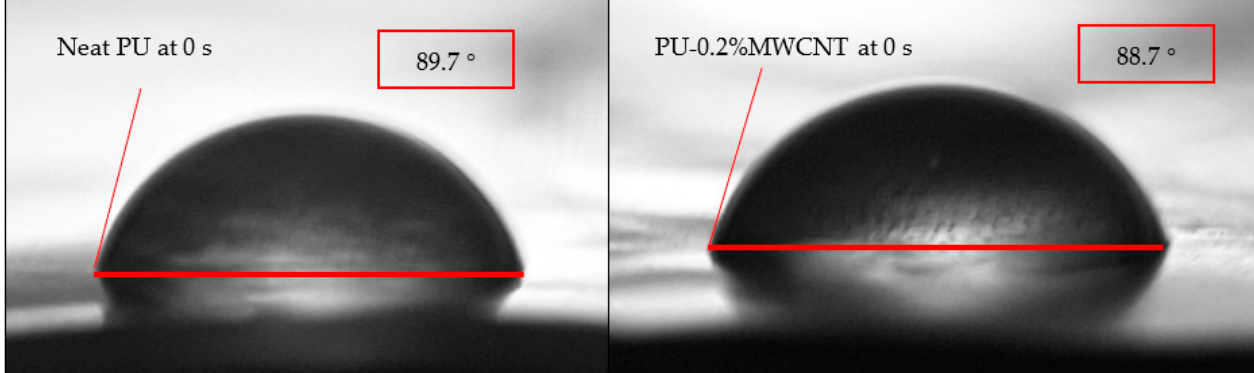
Figure 10. Drop appearance for neat PU and PU-0.2%MWCNT at 0 s during water contact angle experiments.